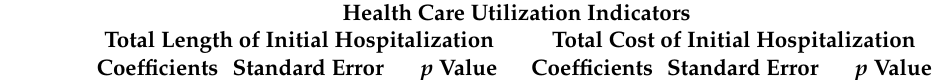
Table 3. Multiple regression analysis with GEE models for the July effect and weekend effect on total length and cost of initial hospitalization in patients with